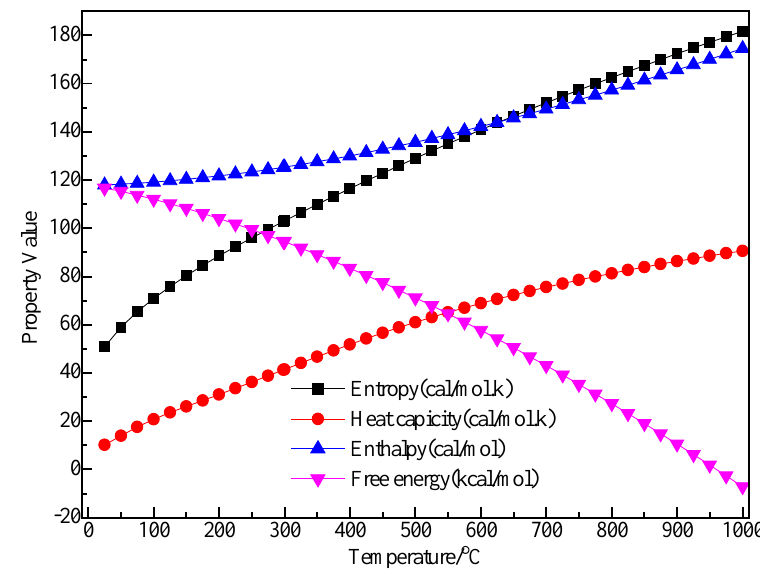
Figure 8. Molecular model of (C 2 H 5 ) 3 Al molecule. ( a ) Initial model; ( b ) Optimized model. The unit of the angle in the image is (°), and the unit of the bond length is angstrom (Å).